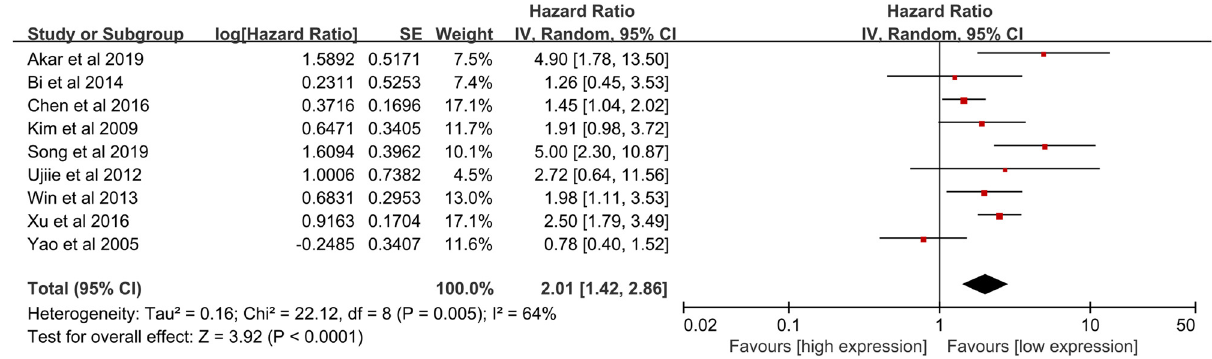
Figure 2: Meta - analysis for the association between NNMT expression and OS indicating that high NNMT expression was signi fi cantly associated with worse OS compared to low NNMT expression in cancer patients.